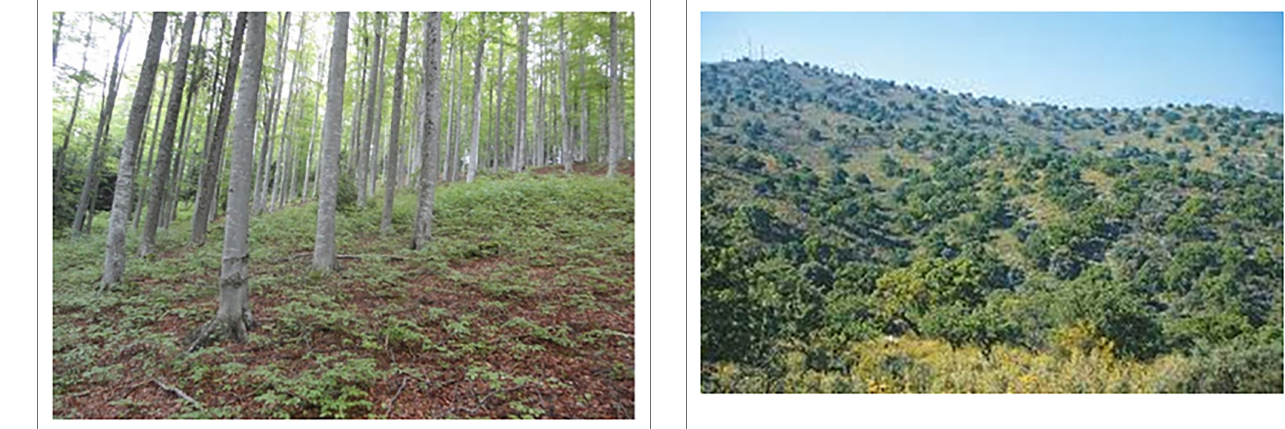
FIGURE 4 | Image for the category of mountainous beech forest . Source : LIFE SySTEMiC project. Reproduced with permission from LIFE SySTEMiC project, available at https://www.lifesystemic.eu/.